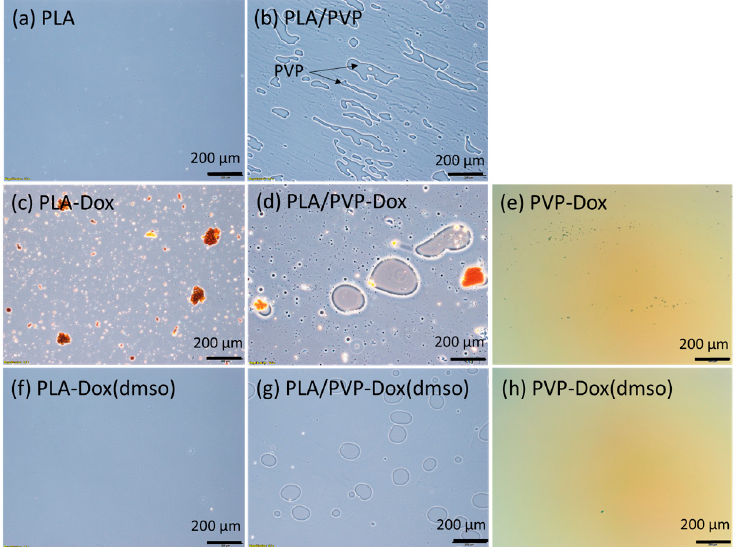
Figure 2. Microscopy images of polylactic acid (PLA) solution with homogenous single phase and PLA/polyvinylpyrrolidone (PVP) solution with phase separation.